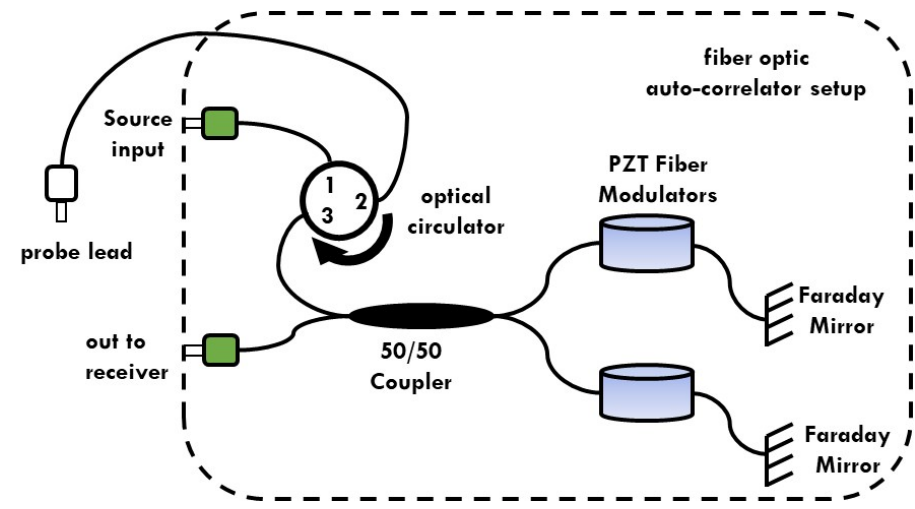
Figure 9. Scheme of an all-fiber autocorrelator for thickness measurement: the beating happens between the reflections from the two film surfaces.